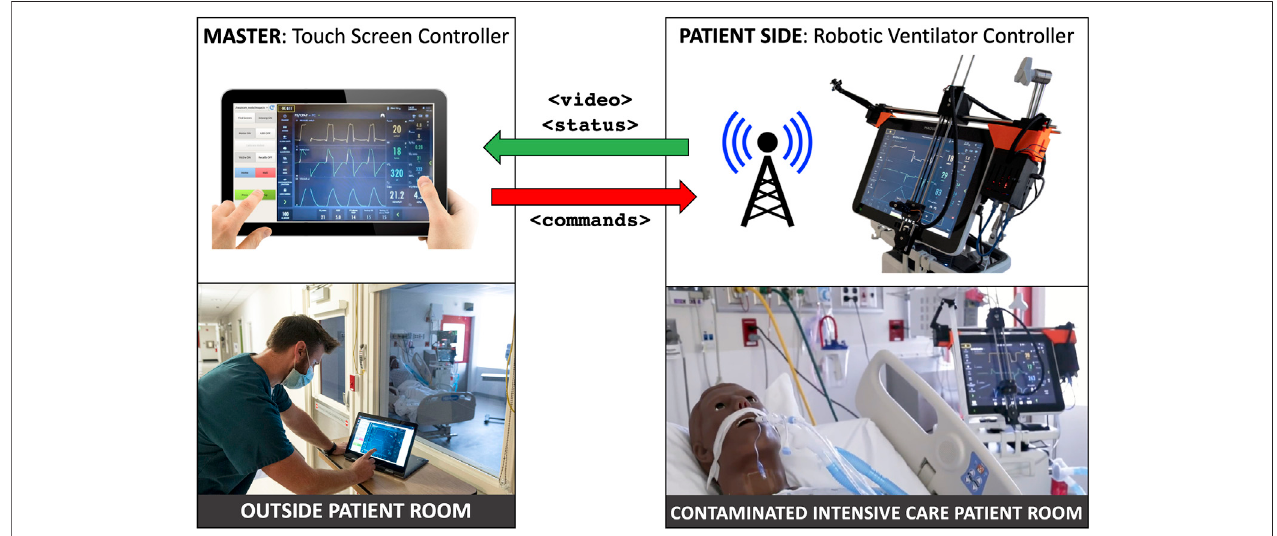
FIGURE1| Systemoverview:ventilator-mountedcamerastreamsvideotomastertouchscreen; healthcareworkeroutsidepatientroompressesbuttonsonvideo displayed on master touchscreen, which sends commands to ventilator-mounted robot to move to and press buttons on the actual ventilator touchscreen.